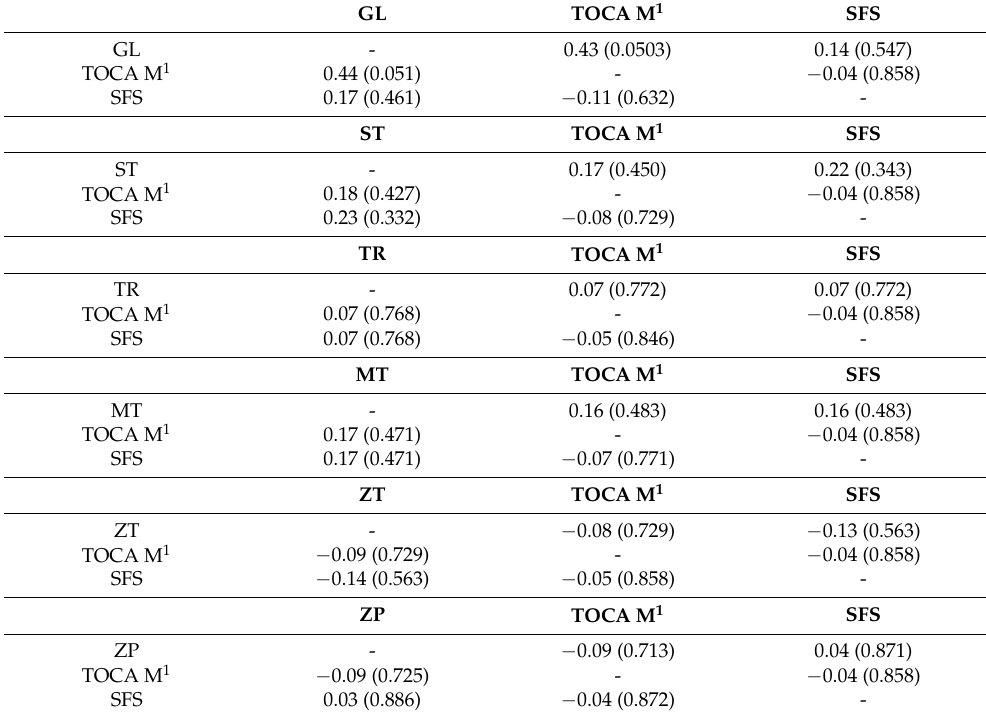
Table 6. Results of Spearman’s rank correlation analysis (top) and partial rank correlation analysis (bottom) obtained for examined traits including the TOCA of M 1 s—female cranial sample.